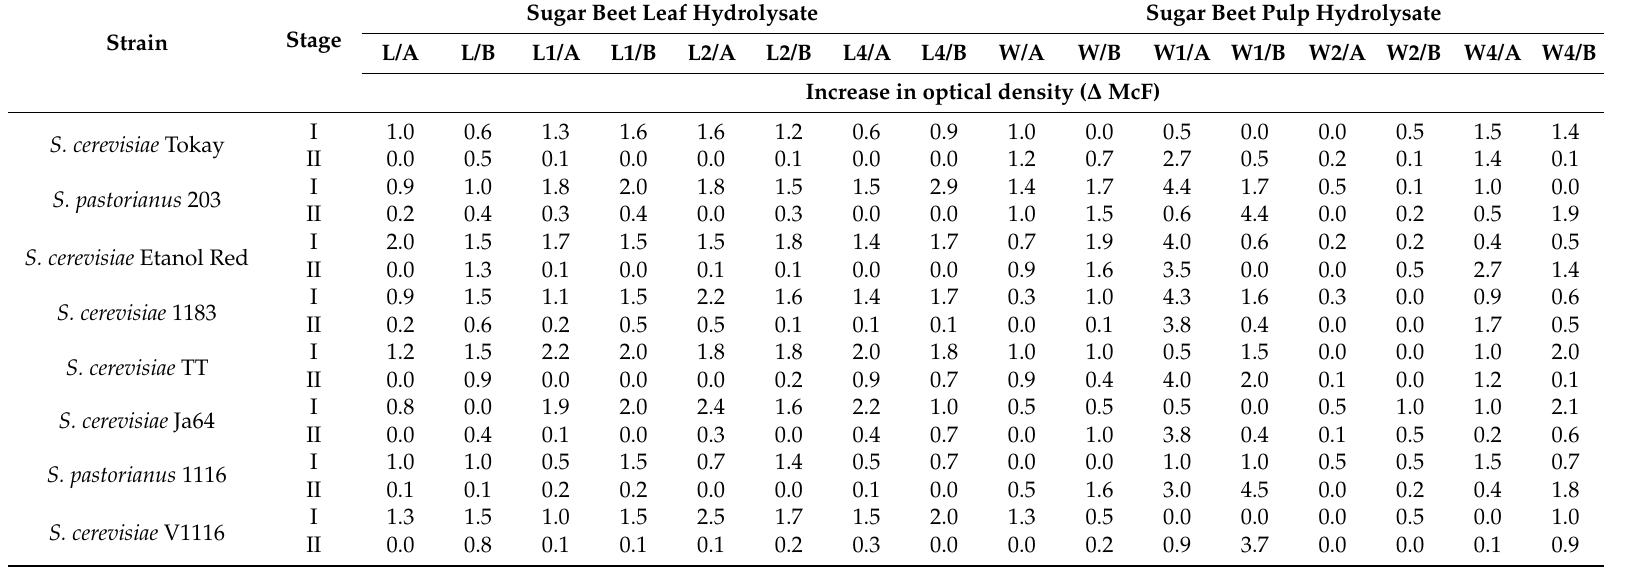
Table 5. Growth of selected industrial yeast strains on biomass